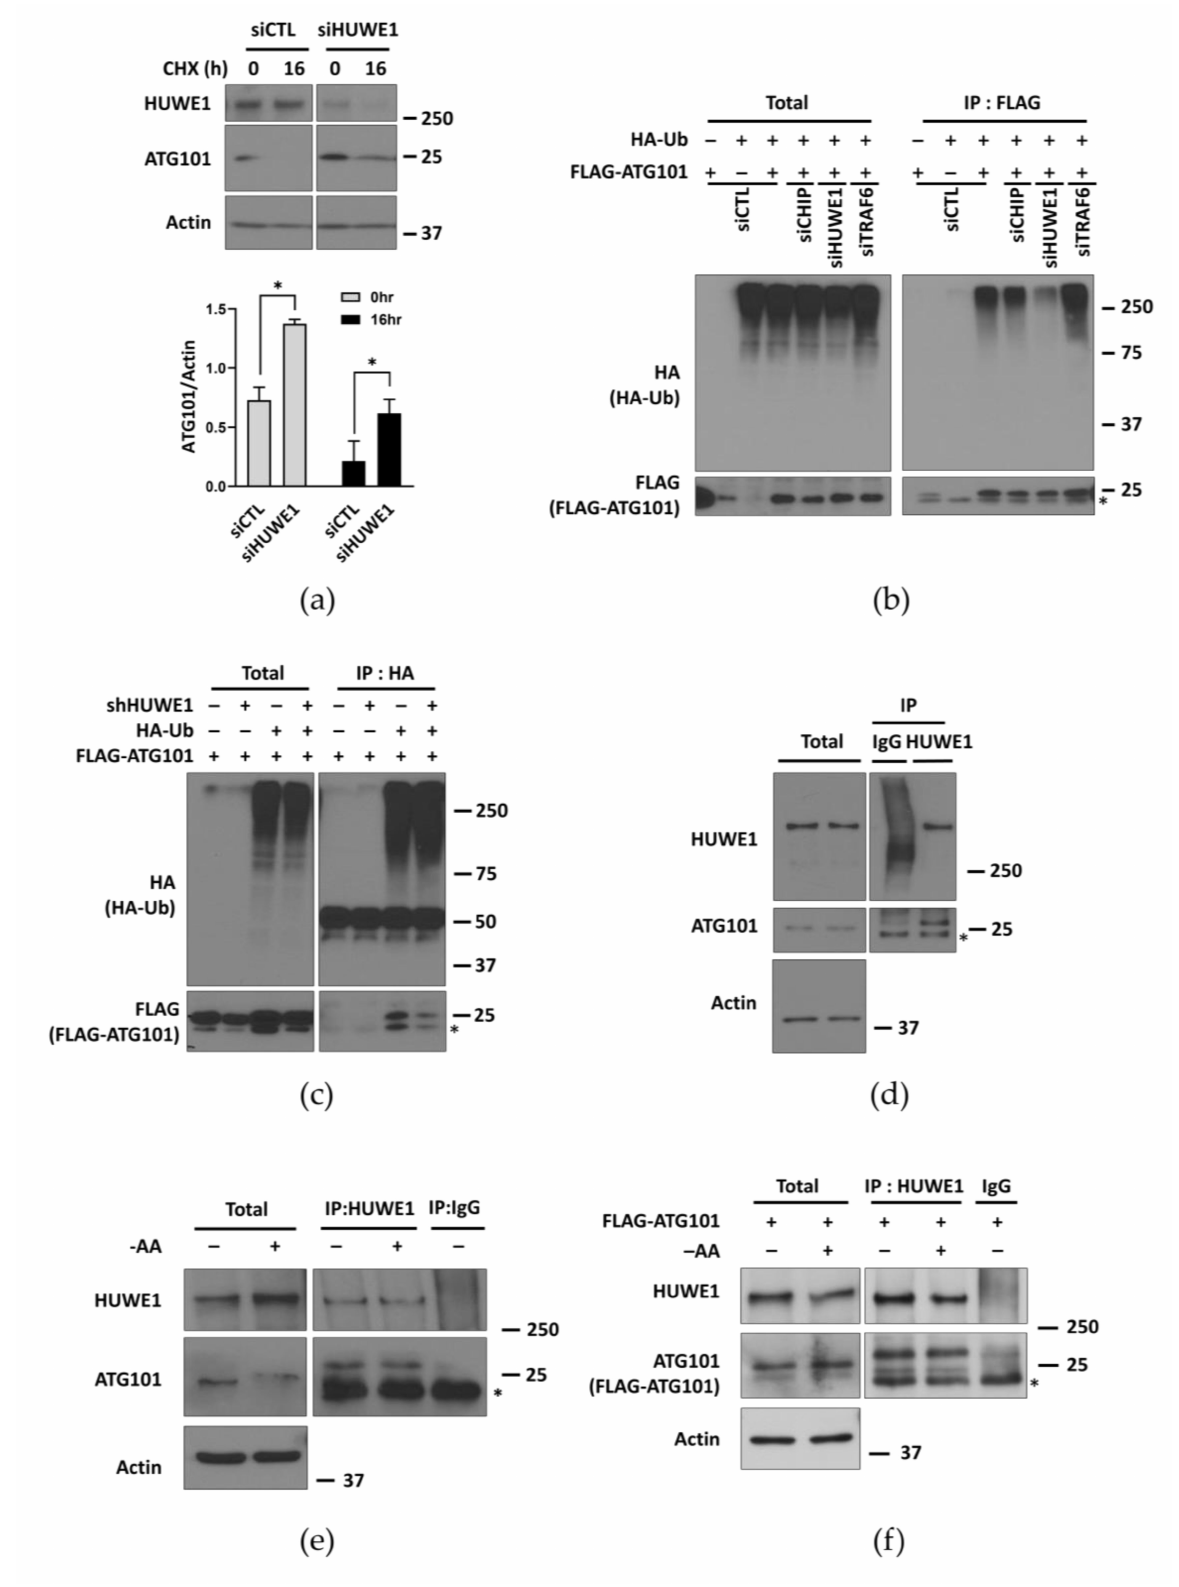
Figure 3. HUWE1 mediates ATG101 ubiquitination and degradation. ( a ) HUWE1 knockdown (KD) in MIA PaCa-2 cells increased ATG101 protein levels as measured by western blotting. MIA PaCa-2 cells were incubated with HUWE1